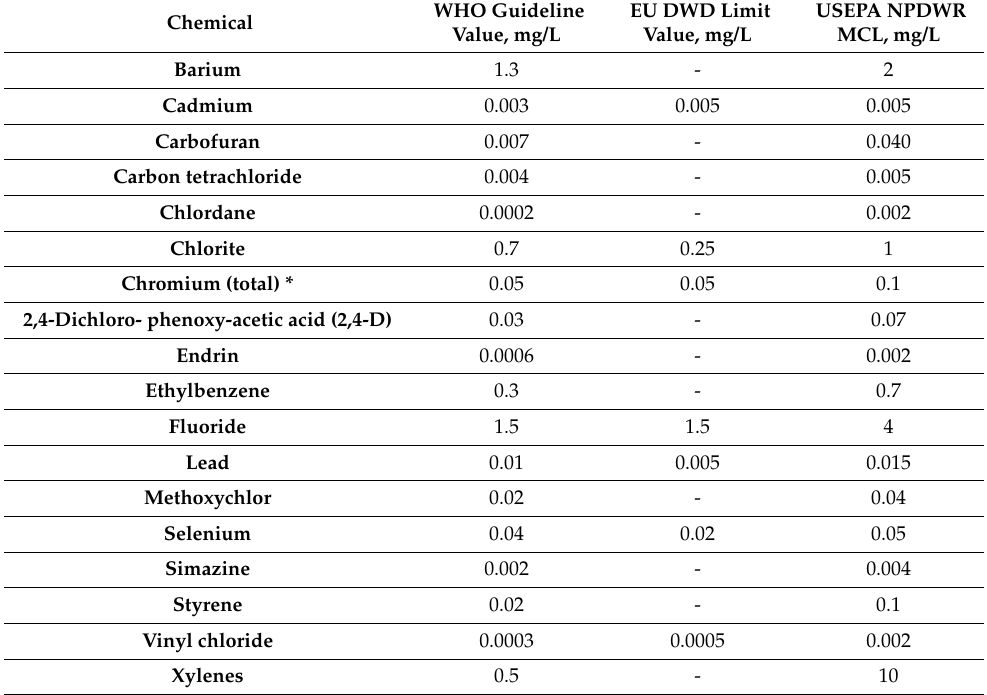
Table 2. Comparison of parametric limit values for some DW chemical contaminants as set by the EU, USEPA, and WHO [5,6,22]. The standard values of the listed contaminants (set either by USEPA’s NPDWR, the EU DWD, or both) are higher than those of WHO